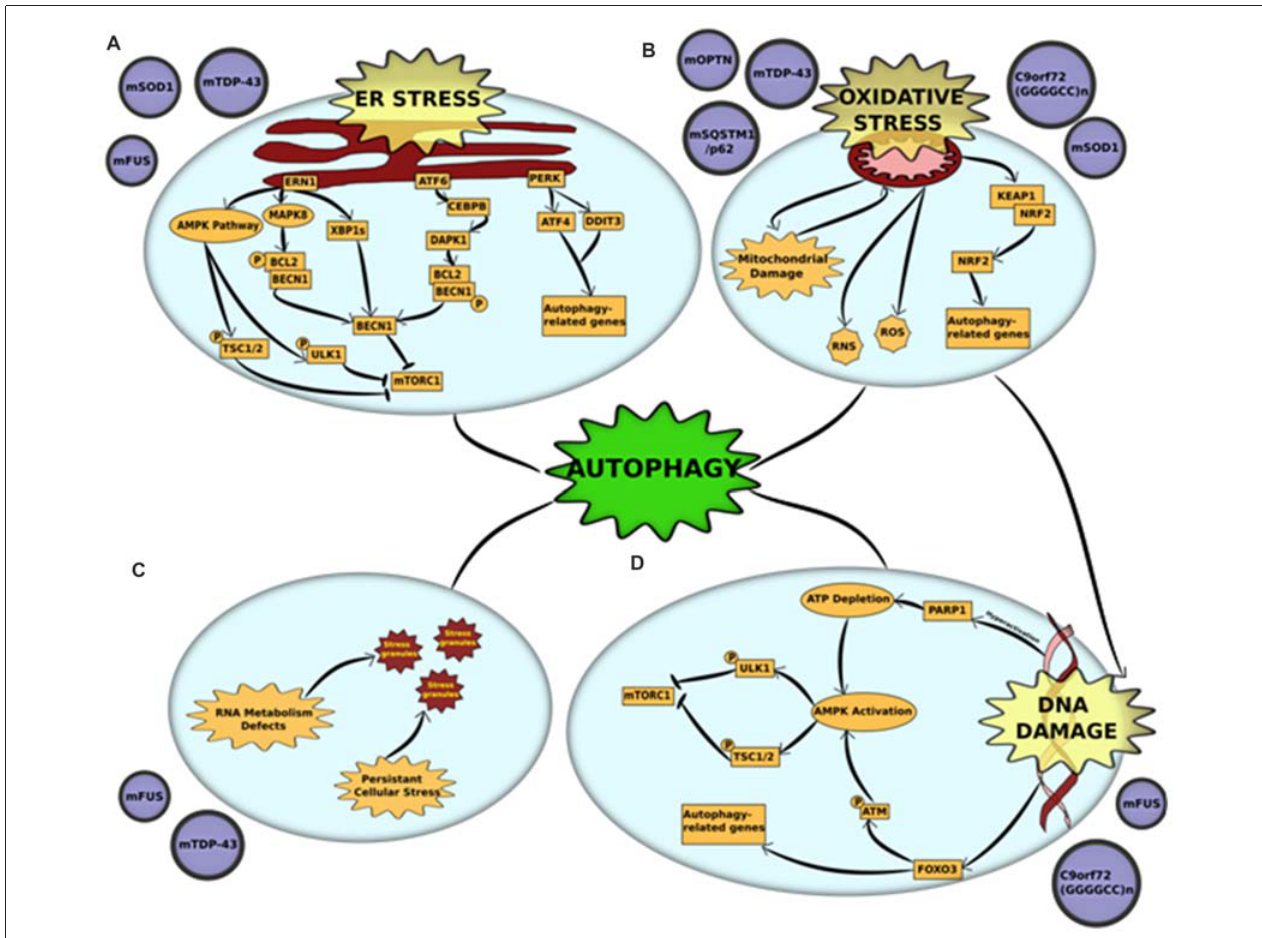
FIGURE 1 | Cross-talk between autophagy and other pathogenic mechanisms in amyotrophic lateral sclerosis (ALS) (A) endoplasmic reticulum (ER) stress and unfolded protein response (UPR) is triggered by mutations in superoxide dismutase 1 (mSOD1), TAR DNA-binding protein 43 (TDP-43) and fused in sarcoma (FUS). Accumulation of misfolded mutant proteins activates either one or all three UPR pathways—protein kinase RNA-like endoplasmic reticulum kinase (PERK), endoplasmic reticulum to nucleus signaling 1 (ERN1) and activating transcription factor 6 (ATF6). Each of the pathways stimulate autophagy through downstream activators. ERN1 activates autophagy through three pathways—(i) the AMPK pathway phosphorylates and activates two proteins—ULK1 and tuberous sclerosis protein 1/2 (TSC1/2)—both of which inhibit mammalian target of rapamycin complex 1 (mTORC1) which leads to initiation of autophagy; (ii) ERN1 activates mitogen-activated protein kinase 8 (MAPK8), which uses its kinase activity to phosphorylate B-cell lymphoma 2 (BCL2) which is in a complex with Beclin-1 (BECN1). This phosphorylation disrupts the complex and releases BECN1, which in turn activates autophagy through mTORC1 inhibition; (iii) ERN1 also acts an endoribonuclease to splice XBP1. The spliced version of XBP1 (XBP1s) promotes expression of BECN1. The UPR activator ATF6 activates the transcription factor CCAAT/enhancer-binding protein beta (CEBPB) that promotes expression of the kinase death-associated protein kinase 1 (DAPK1). DAPK1 phosphorylates BECN1 and thus breaks it from its complex with BCL2. The free BECN1 now activates autophagy through mTORC1 inhibition. The third UPR activator, PERK, activates the expression of two stress response genes—activating transcription factor 4 (ATF4) and DNA damage inducible transcript 3 (DDIT3). These genes promote the transcription of autophagy-related genes (ATGs) that activate the process. (B) Oxidative stress and mitochondrial dysfunction are complimentary mechanisms that are triggered by mutations in optineurin (mOPTN), TDP-43, SQSTM1/p62, SOD1 and C9orf72 GGGGCC expansion. Mitochondrial dysfunction is the primary source of reactive oxygen and reactive nitrogen species (ROS and RNS) that are directly implicated in activating autophagy. An alternative mechanism is through the Kelch-like ECH-associated protein 1 (KEAP1)-nuclear factor erythroid 2-related factor 2 (NRF2) pathways. Oxidative stress KEAP1-NRF2 complex is disrupted. This leaves NRF2 free to translocate to the nucleus where it induces the expression of several autophagy-related genes. Autophagy also acts to clear damaged mitochondria through an organelle-specific mechanism called mitophagy. (C) RNA metabolism defect is a major pathological outcome of mutations in RNA-binding proteins, especially FUS and TDP-43. These proteins are major components of stress granules and mutations in low complexity domains of these proteins alter the phase of stress granules to give them a complex liquid state. This alters the dynamics of stress granules, in that, they are not cleared and potentially act as primers for protein aggregates. Autophagy is a crucial mechanism involved in the clearance of stress granules under normal conditions and dysfunction in autophagy could be linked to altered stress granule dynamics. (D) DNA damage, either caused as a direct result of pathogenic mutation or triggered by oxidative stress, is a common pathological feature of mutations in FUS and C9orf72 GGGGCC expansion. DNA damage activates autophagy through activation of AMPK pathway. The AMPK pathway phosphorylates and activates two proteins, ULK1 and TSC1/2, both of which independently act as mTORC1 inhibitors. DNA damage activates the AMPK pathways through: (i) Hyperactivation of PARP1, which leads to a depletion of NAD + reserves in the cell. This, in turn, depletes ATP and thus activates AMPK; or (ii) FOXOa3 dissociation from DNA that allows it to interact with ATM. Activation of ATM by phosphorylation leads to downstream activation of AMPK pathway. Alternatively, FOXOa3 also acts as a transcription factor that regulates expression of autophagy-related genes.